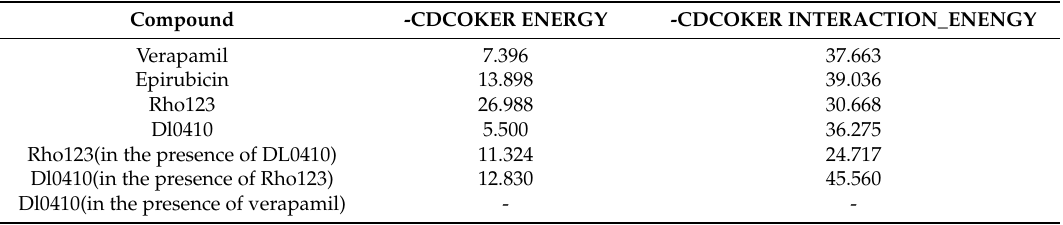
Figure 6. The binding mode of DL0410 to human P-glycoprotein. DL0410 has a good affinity of the drug binding pocket in P-gp. The Figure showed the 3D and 2D interaction. The amino acid residues of the DBP interacting with DL0410 included Leu65, Ile340, Ser344, Phe343, Gln347, Phe728, Ala729, Phe732, Phe978, and Val982 mainly via hydrogen bonding, and π -alkyl and π - π stacked interactions. Table 3. The CDOCKER analysis of verapamil, epirubicin, Rho123, and DL0410 at the DBP site of P-gp.